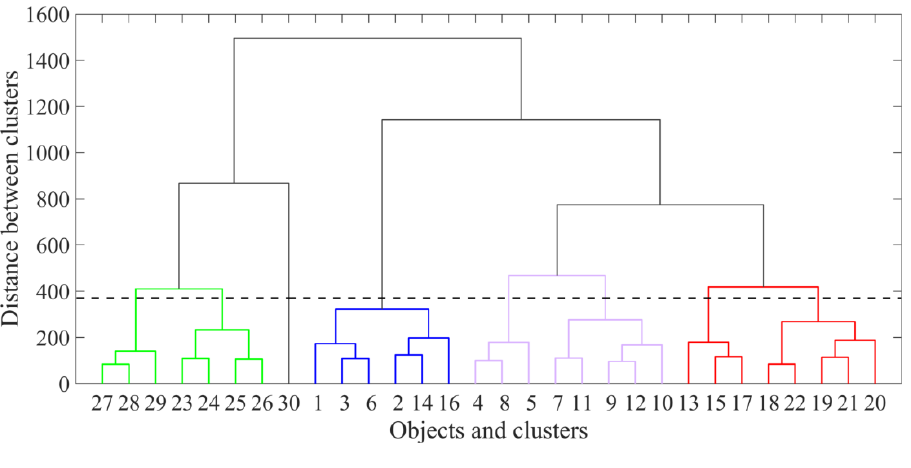
Figure 5. Dendrogram: the traffic flow–percentage of trucks pairs attributed to correct/natural/optimal clusters.